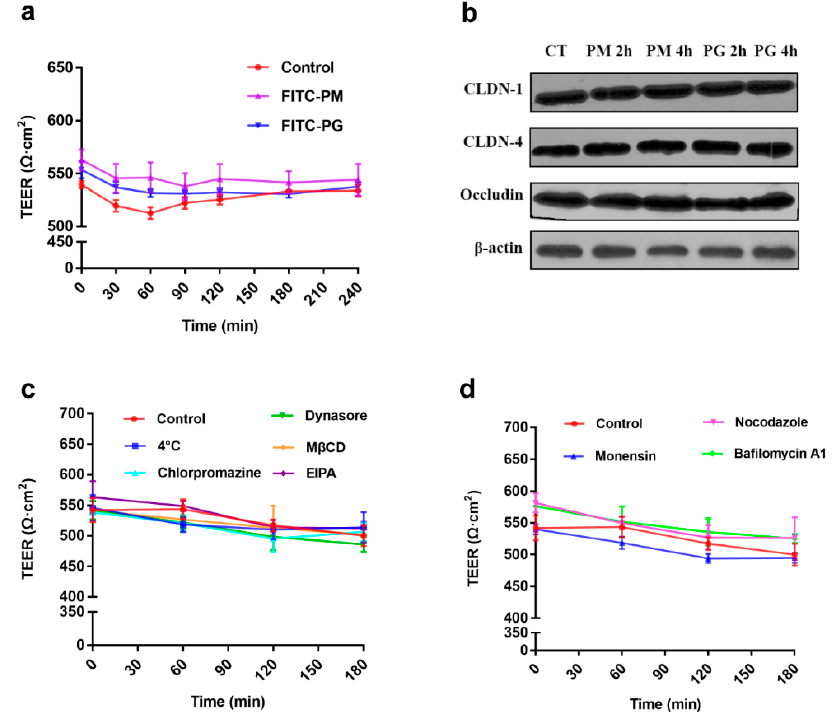
Figure 4. Transport-dependent changes in the TEER value and the impact of F-PM and F-PJ on tight junctions (TJ). ( a ) Effects of F-PM and F-PG on TEER during transport; ( b ) effects of F-PM and F-PG on tight junction proteins; ( c ) effects of the addition of transport inhibitors on TEER; ( d ) effects of the addition of intracellular inhibitors on TEER. Table 6. Translocation of F-PM and F-PG at different times.